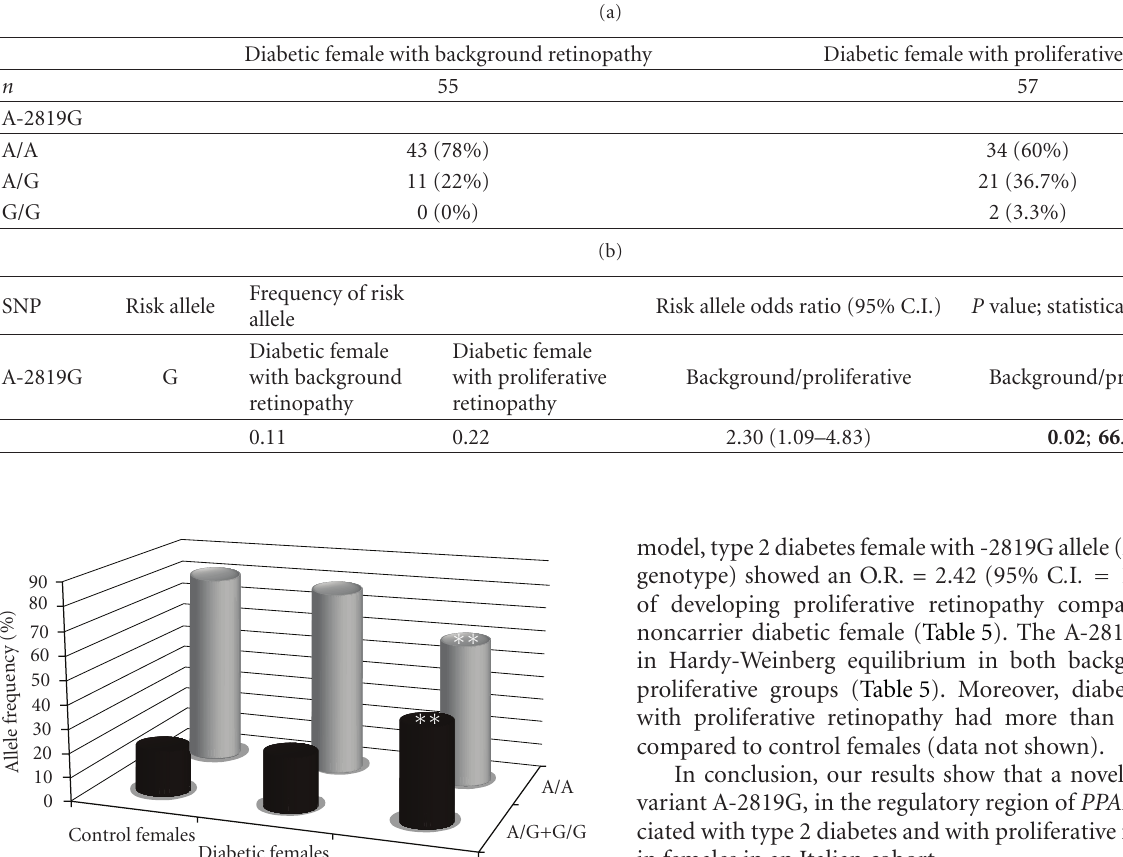
Table 4: Genotypes and -2819G frequency in diabetic women with and without proliferative retinopathy (statistical significant values are in bold).